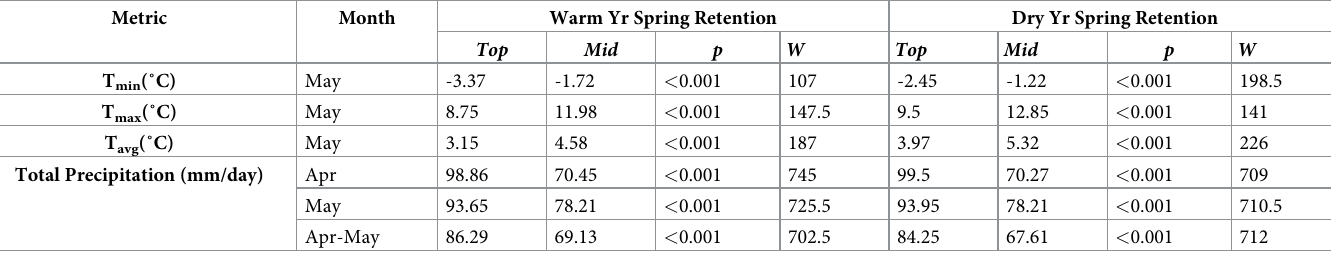
Table 5. Temperature and precipitation influences on spring